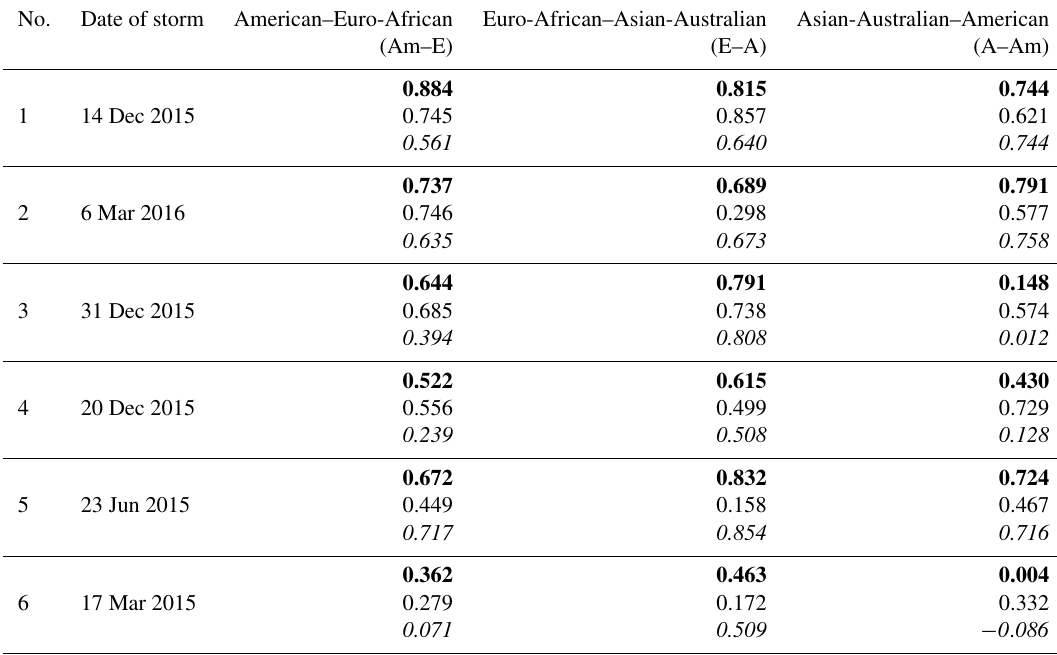
Table 2. Correlation coefficients between δ TEC along the three